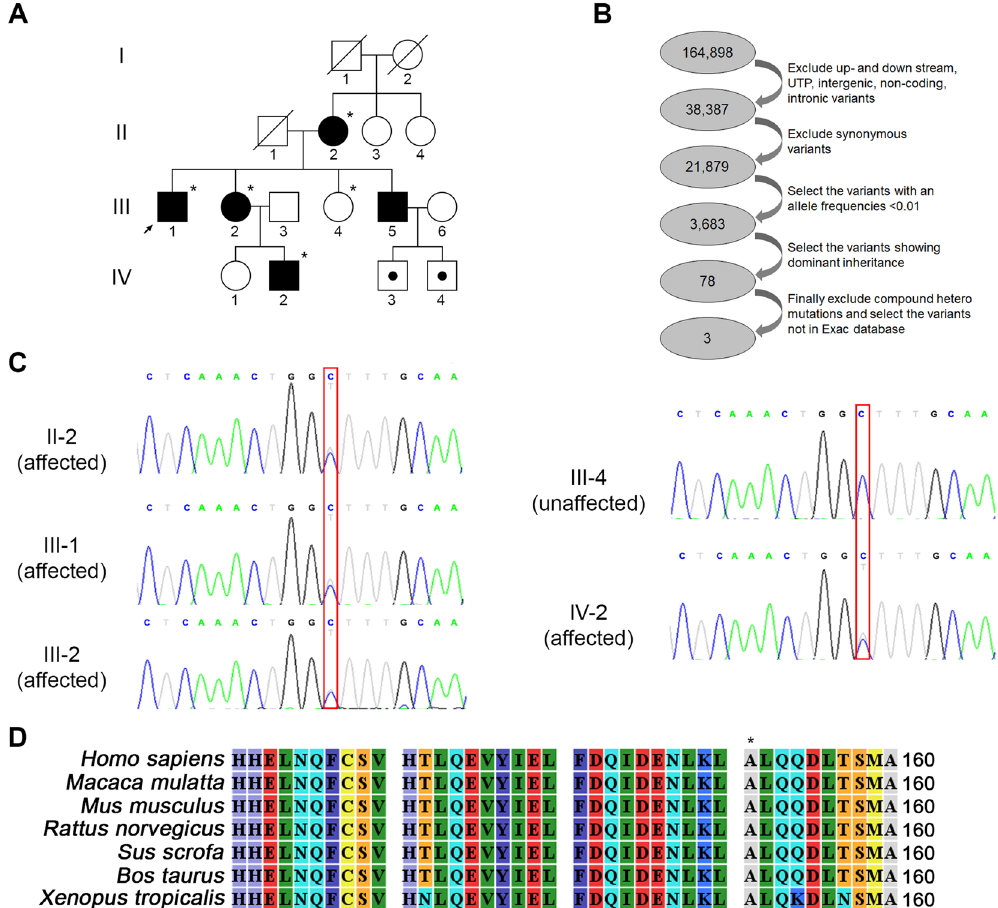
Figure 1. Analysis of ERLIN2 mutation in a family. ( A ) The family pedigree is a three-generation pedigree with eight individual family members. The arrow indicates the proband and the asterisks indicate the individuals evaluated in this study. ( B ) Variants revealed by whole-exome sequencing of five family members were filtered out. The filtering strategy and the number of remaining variants at each step are shown. ( C ) The partial nucleotide sequences of exon 7 of ERLIN2 show the c.452 C > T mutation in the affected family members (II-2, III-1, III-2, IV-2). ( D ) Multiple alignments of the ERLIN2 partial region using CLC sequence viewer 6. Amino acid sequence of human ERLIN2 was aligned with that of other species. The asterisk represents amino acid position 151 in human